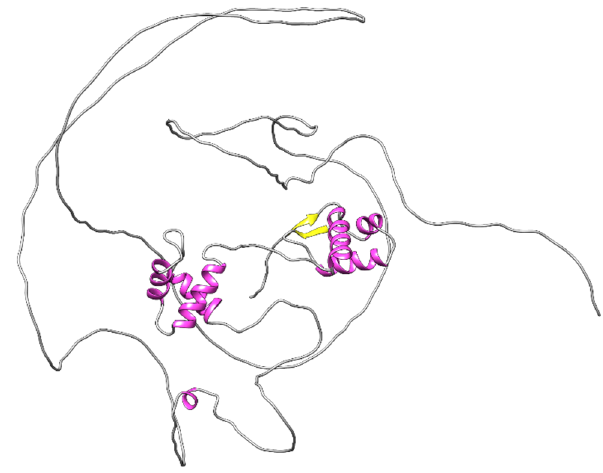
Figure 1. Alpha fold prediction of the structural organization of the PAX8 protein. The PAI and RED subdomains that are composed of helix-turn-helix motifs are seen in pink. A β hairpin is seen in yellow at the N-terminus of the PAI subdomain. Both PAI and RED subdomains are predicted to bind DNA. The octapeptide, homeodomain, and transactivation domains are predicted to be disorganized structures [40,41].